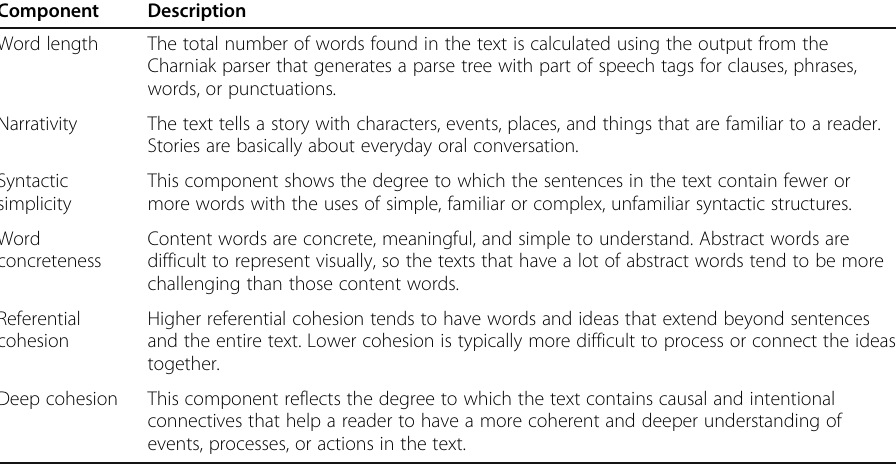
Table 1 The six discourse components and linguistic